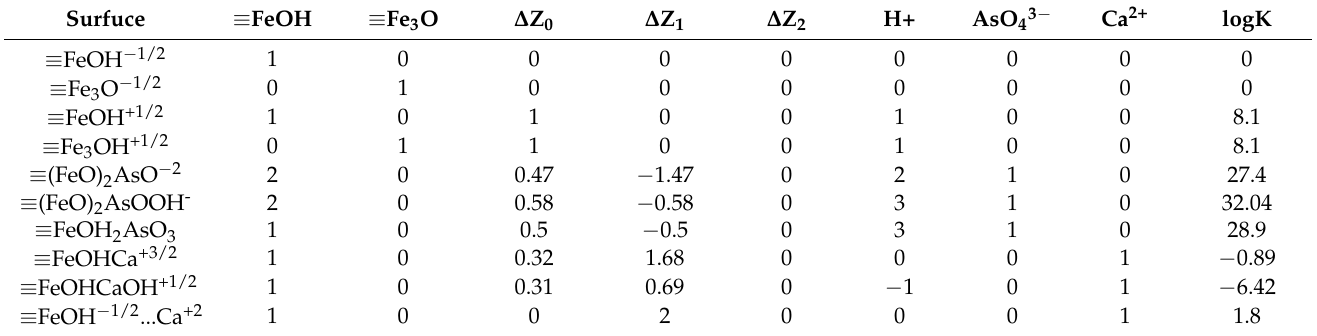
Table 1. Surface species and CD model parameters for H + , AsO 43- , and Ca 2+ binding to